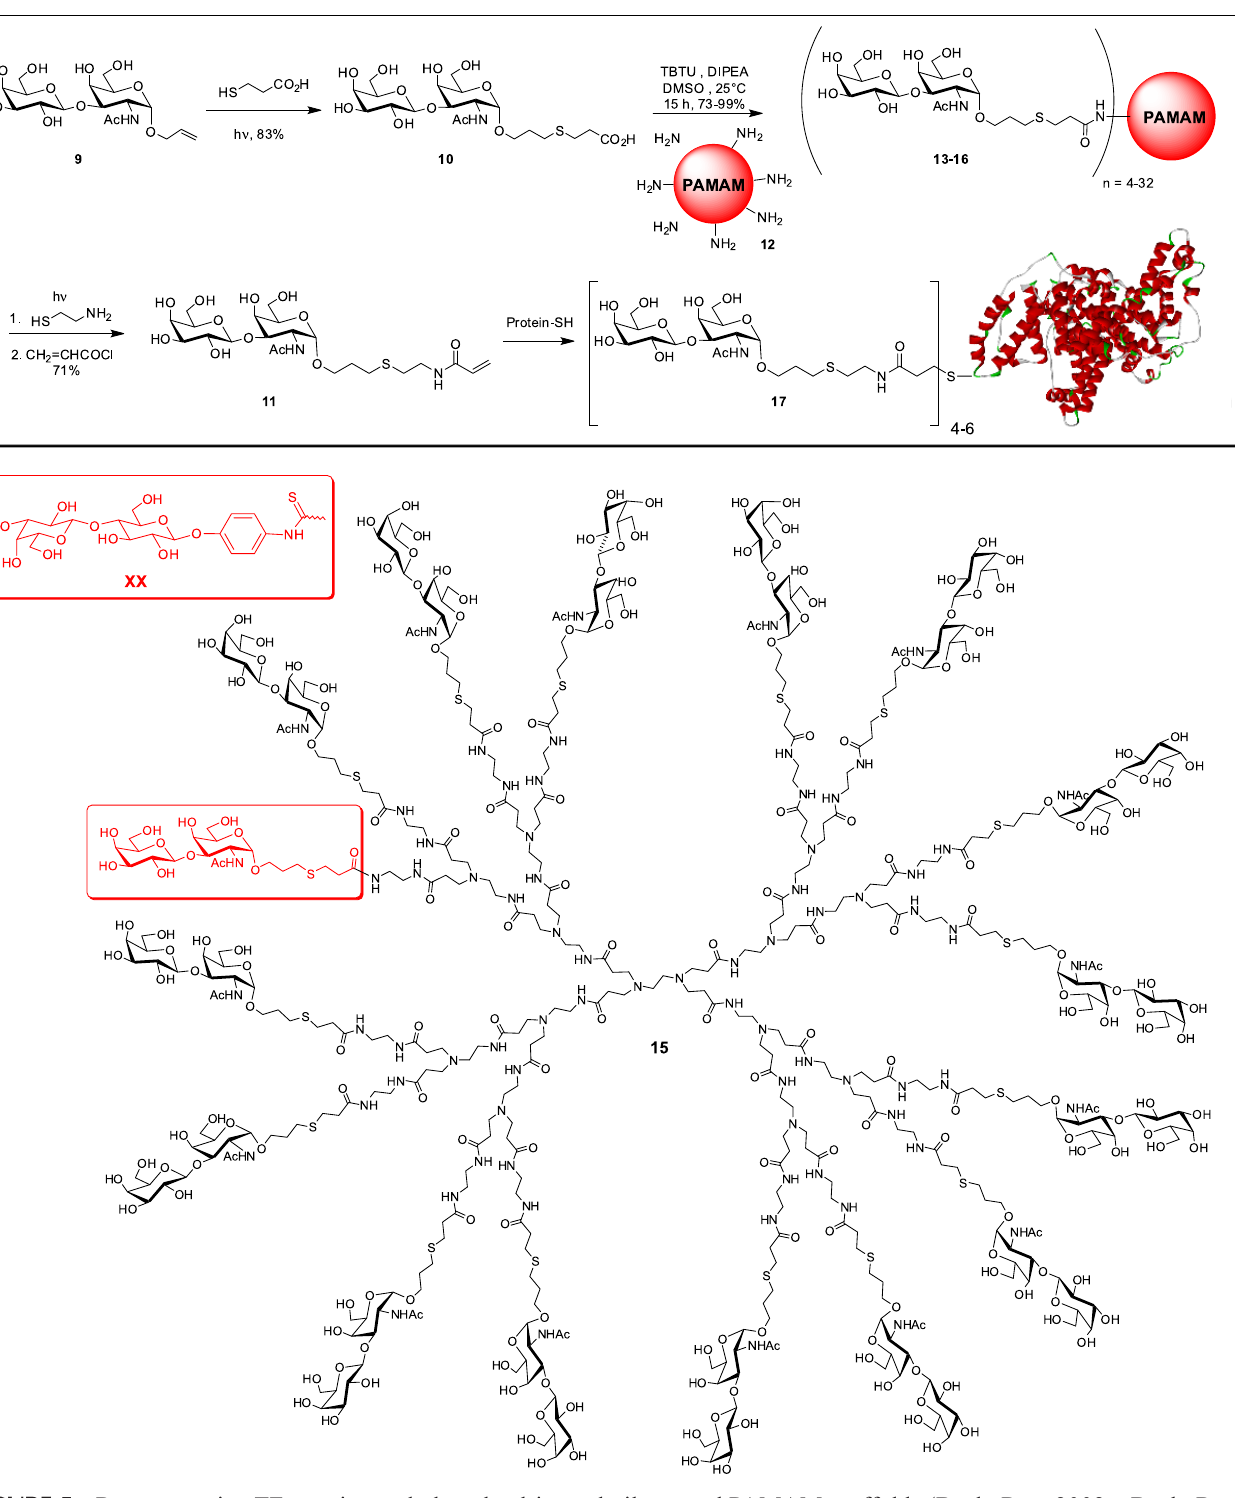
FIGURE 5 - Representative TF-vaccine and glycodendrimers built around PAMAM scaffolds (Baek, Roy, 2002a; Baek, Roy, 2002b). Red inset: Structure of the G3 poly(amidoamine) glycodendrimer after covalent incorporation of p -isothiocyanatophenyl- β -D-lactoside into the peripheral sphere of the starburst PAMAM dendrimer (32-mer) (see section